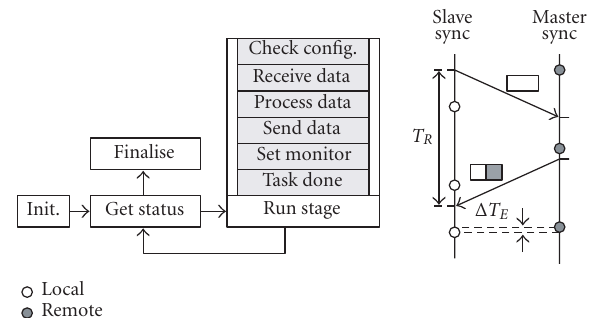
Figure 2: Object task structure and timing synchronisation proce-